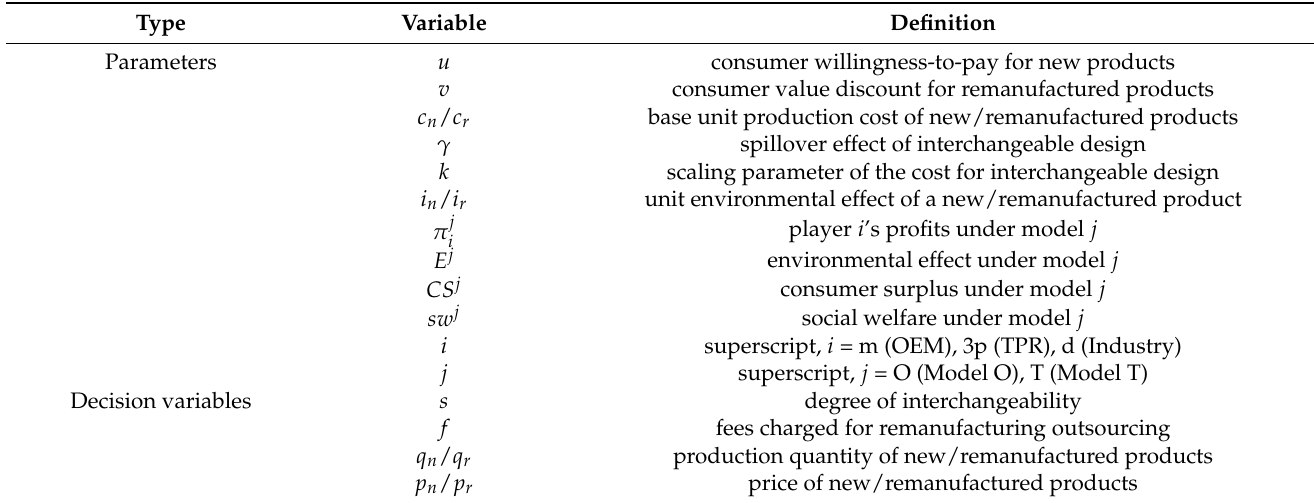
Table 2. Definitions of the primary variables and decision